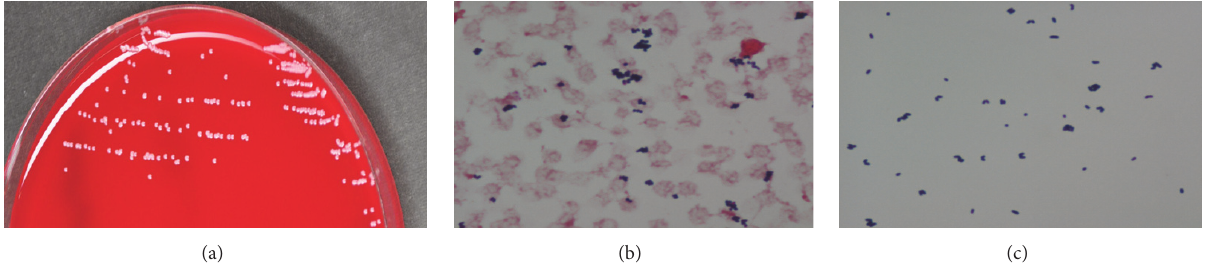
Figure 1: (a) White colonies of 1-2mm diameter of S-type bacteria, observed after incubation of 5% sheep blood agar at 35 ∘ C for 24 hours in carbon dioxide gas culture. (b) Gram-positive coccobacillus revealed by Gram staining in blood sample cultures. (c) Detail of a single colony of Gram-positive bacilli in blood sample cultures.